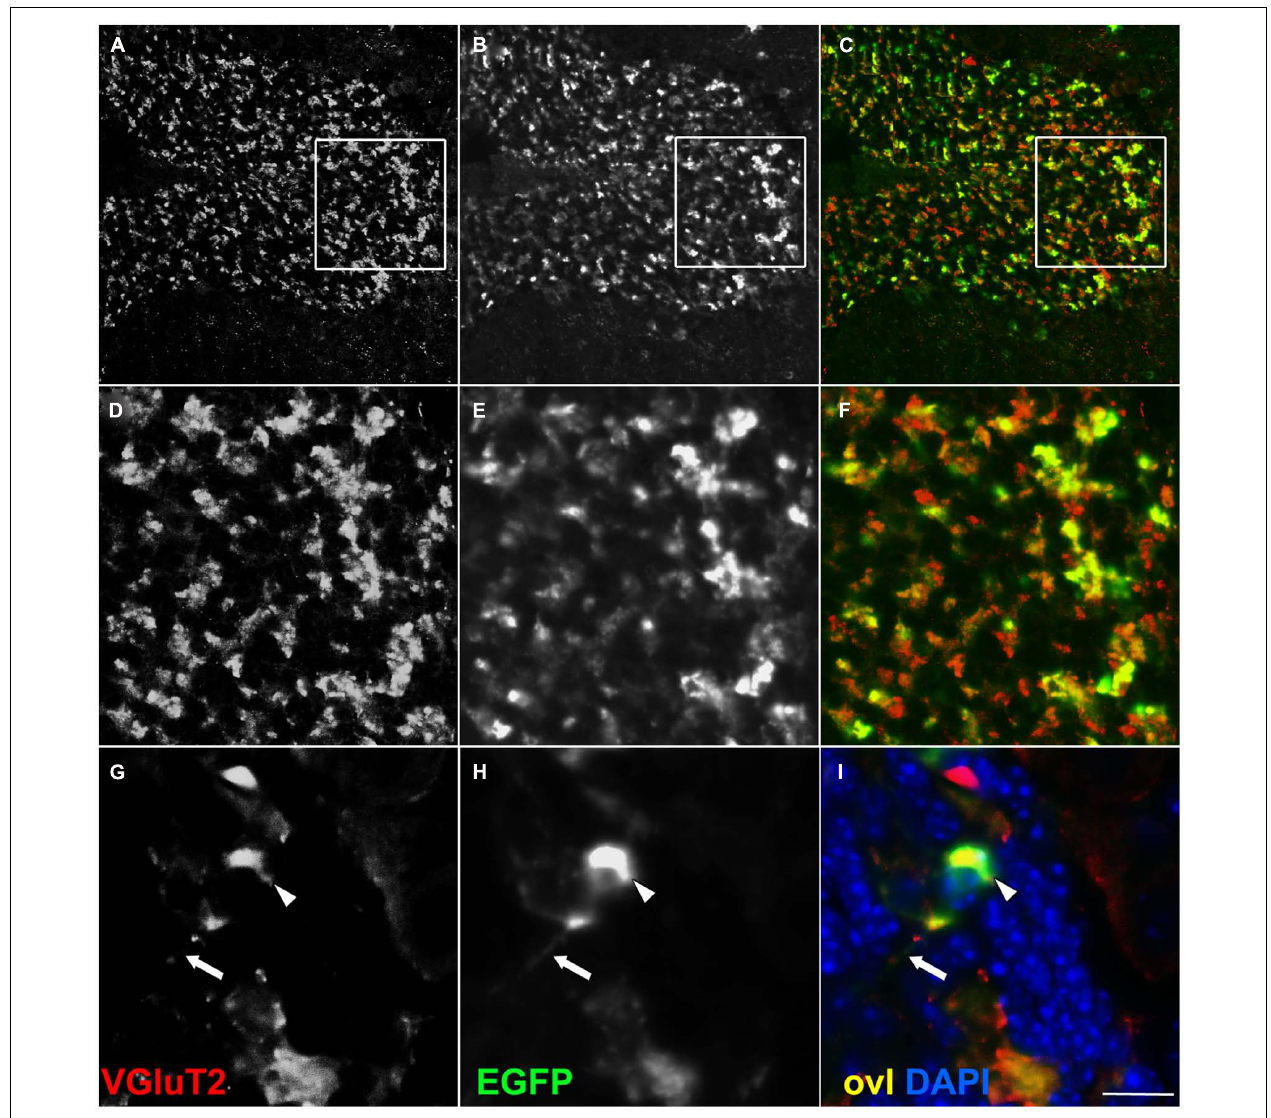
FIGURE 3 | EGFP decorates presynaptic terminals in the internal granule layer of Syn1-Cre Rosa26 EGFP-VAMP2/ + mice. Sagittal sections of an adult cerebellum, immunostained for EGFP (B,E,H) and counterstained for the glutamatergic axon terminal VGluT2 (A,D,G) , which,